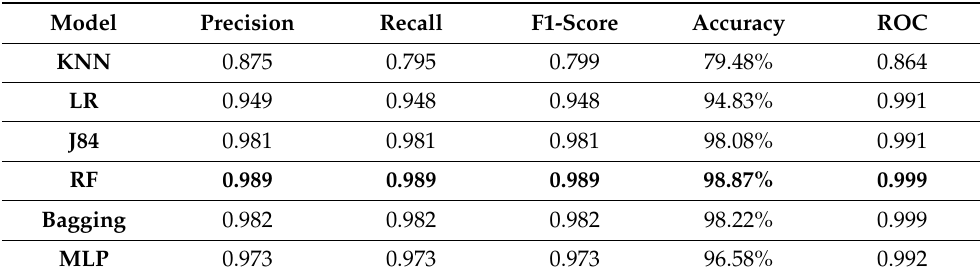
Table 8. Multiclass experiment results before feature